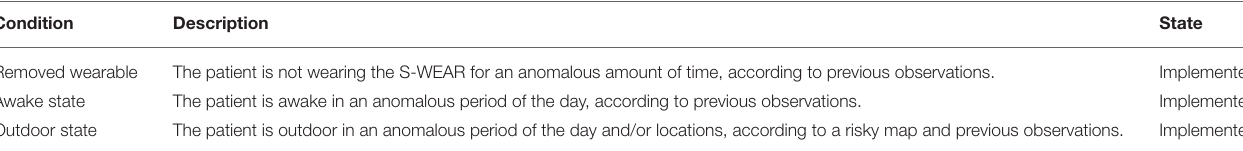
TABLE 5 | Approaches integrated in ATTICUS for the detection of behavior-related anomalies.